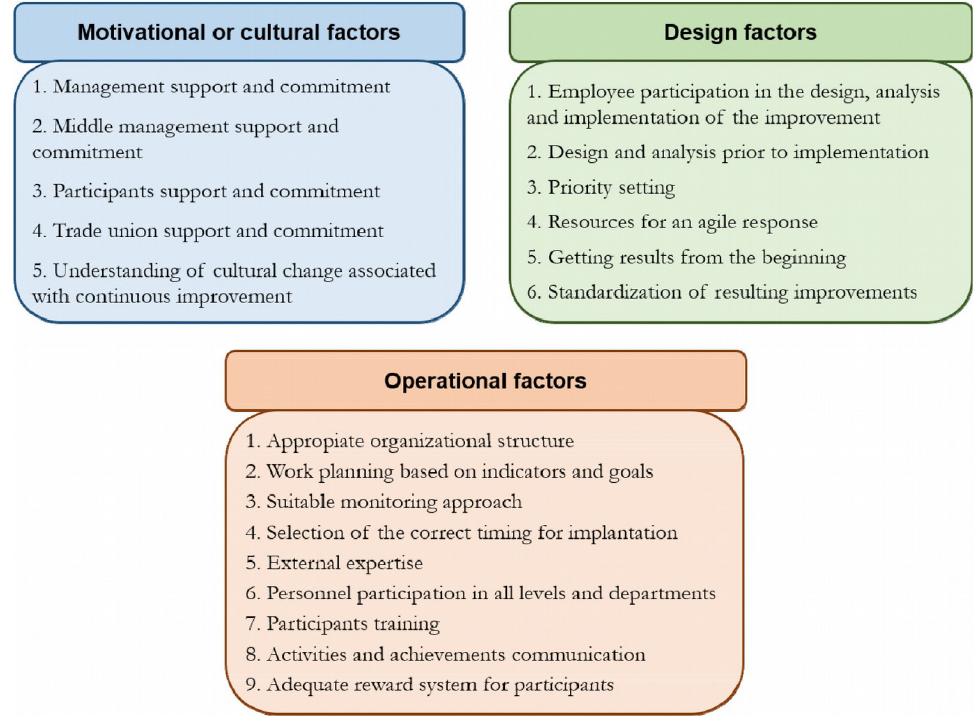
Figure 2. Critical factors for employee participation